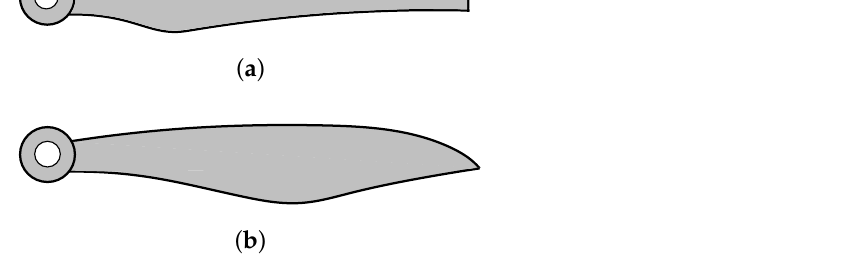
Figure 9. Representation of the considered baseline blade ( a ) and of the new bio-inspired blade ( b